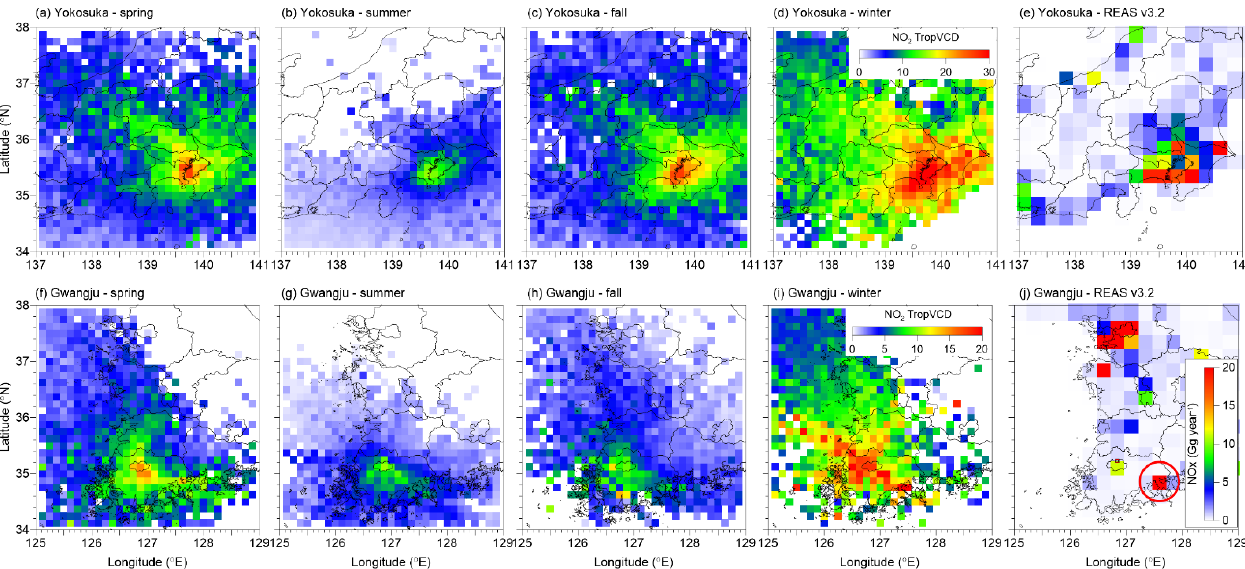
Figure 5. Seasonal spatial distribution of the potential source region of the NO 2 TropVCD ( × 10 15 molecules cm − 2 ) at Yokosuka ( a – d ) and Gwangju ( f – i ) based on a combination of MAX-DOAS measurements and backward trajectories from the HYSPLIT model. The simulation time of the backward trajectories differed depending on the season (12 h in summer, 18 h for spring and fall, and 24 h for winter) by considering the doubling lifetime of NO 2 . NO 2 emission rates are from the REAS emission inventory version 3.2 ( e , j ). The red circle in ( j ) indicates the Yeosu and Gwangyang National industrial complex.